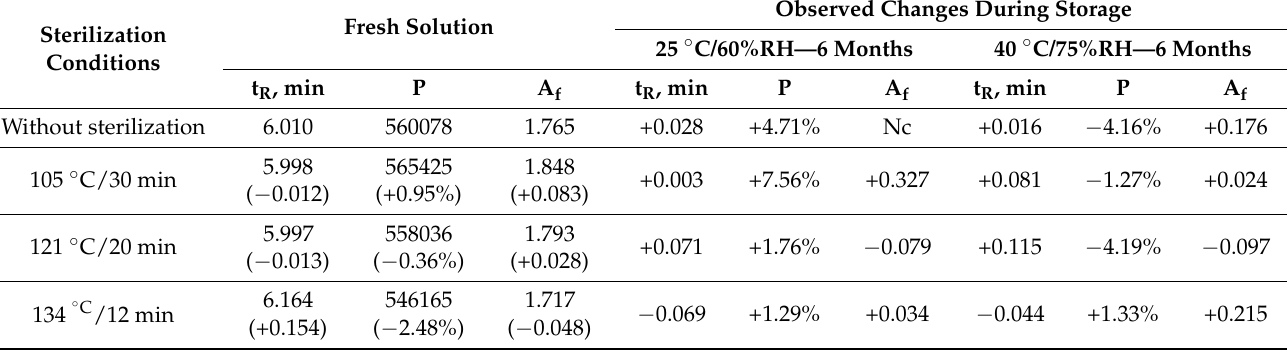
Figure 7. SE C-RID chromatograms: ( A ) HA (0.4%) solution without sterilization and after 6 months of controlled storage; ( B ) HA (0.4%) solution after sterilization at 105 ◦ C (30 min) and after 6 months of controlled storage; ( C ) HA (0.4%) solution after sterilization at 121 ◦ C (20 min) and after 6 months of controlled storage; ( D ) HA (0.4%) solution after sterilization at 134 ◦ C (11 min) and after 6 months of controlled storage (25 ◦ C/60% RH and 40 ◦ C/75% RH). Table 7. Changes of parameters describing SEC-RID chromatograms (retention time, area, asymmetry factor) of HA (0.4%) solutions after sterilization and during storage under the conditions of the accelerated and long-term tests. Changes to the chromatograms of the unsterilized solution are given in